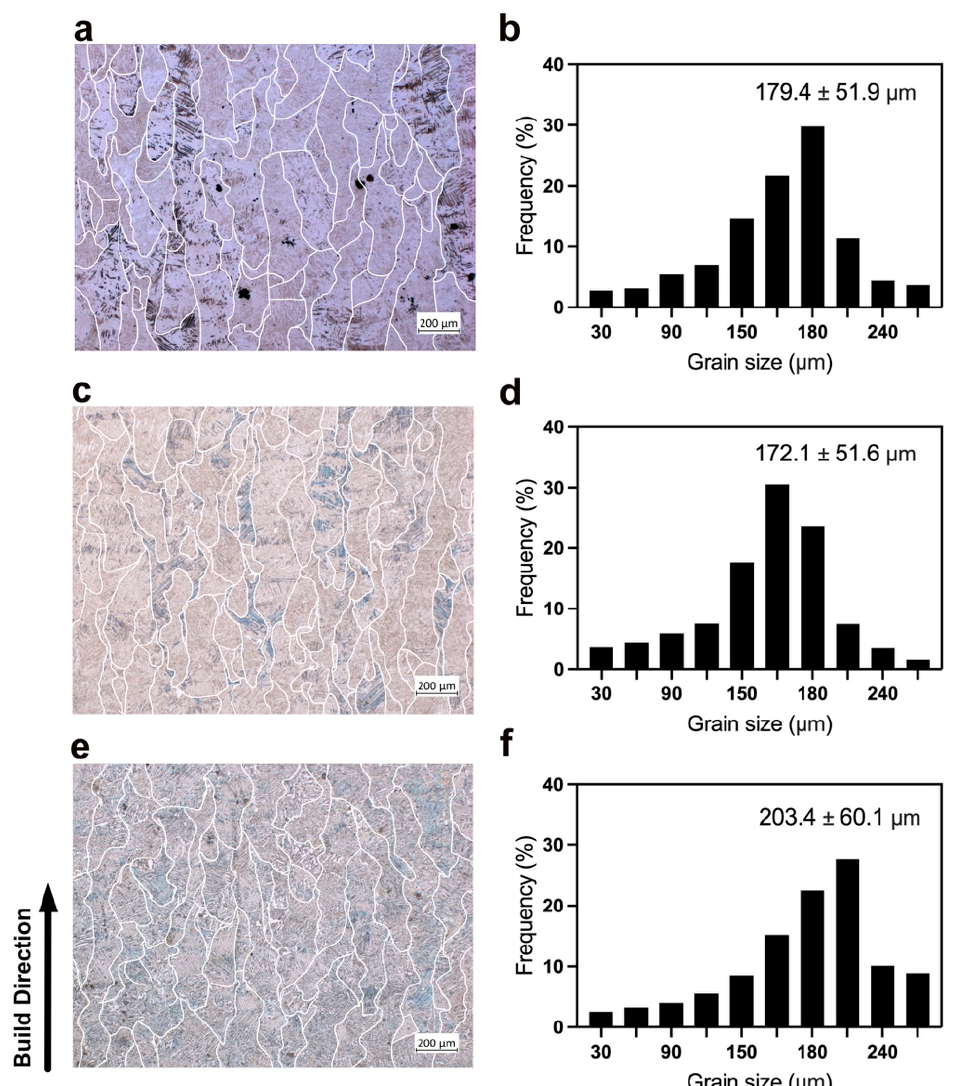
Figure 6. Representative optical microscopy images of ( a ) 950-WQ sample; ( c ) 950-AC sample; ( e ) 950-FC sample. The prior β grain boundaries in ( a , c , e ) are traced by white-color lines. The histograms of prior β -phase grains size are shown in ( b , d , f ).